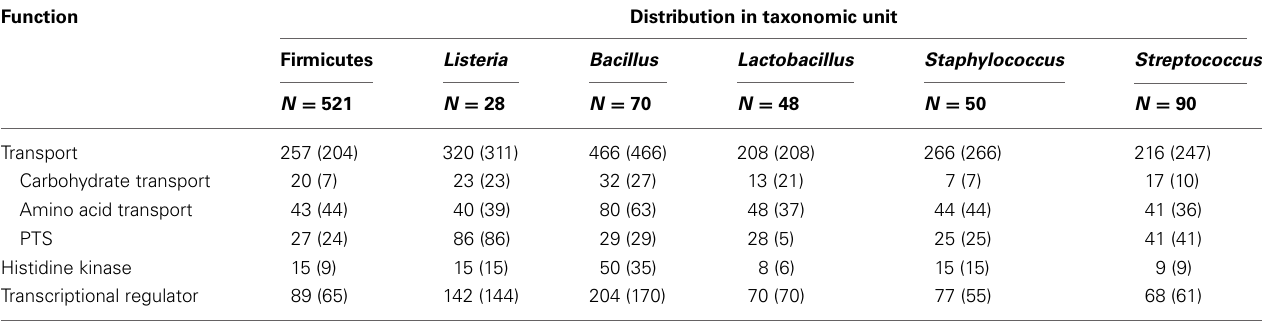
Table 3 | Median number of genes from functional categories transport, histidine kinase and transcriptional regulator across selected genomes.